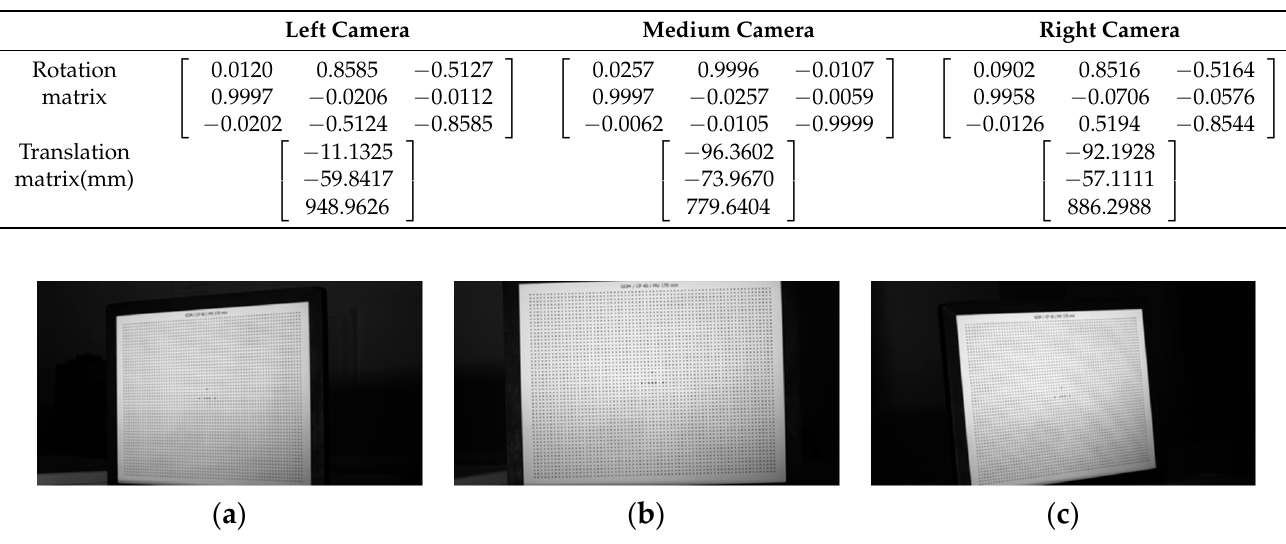
Figure 9. The calibrate template captured by three cameras. ( a ) Imaged by the left camera. ( b ) Imaged by the medium camera. ( c ) Imaged by the right camera. Table 1. Camera calibration parameters and related errors. Std represents the uncertainty of the optimized results.